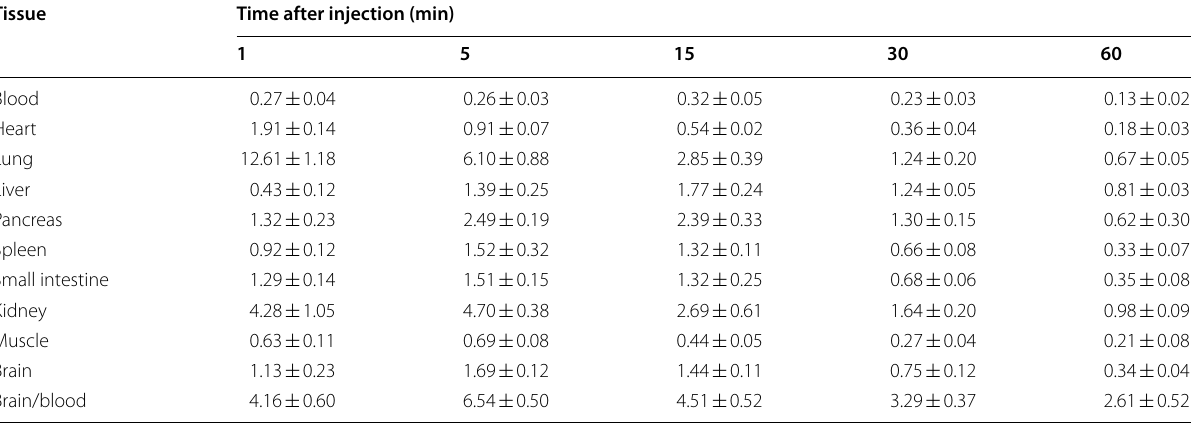
The radioactivity levels are expressed as SUVs Data represent the mean